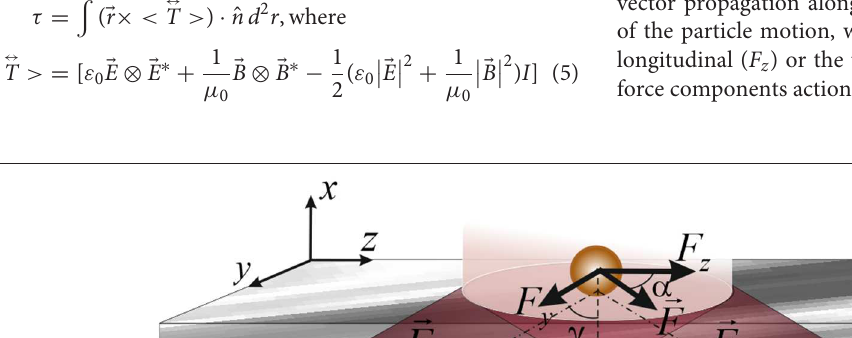
Frontiers in Physics |